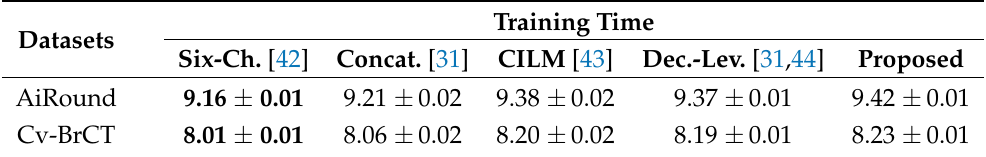
Table 7. Training time (ms per sample) ± STD using different fusion methods.